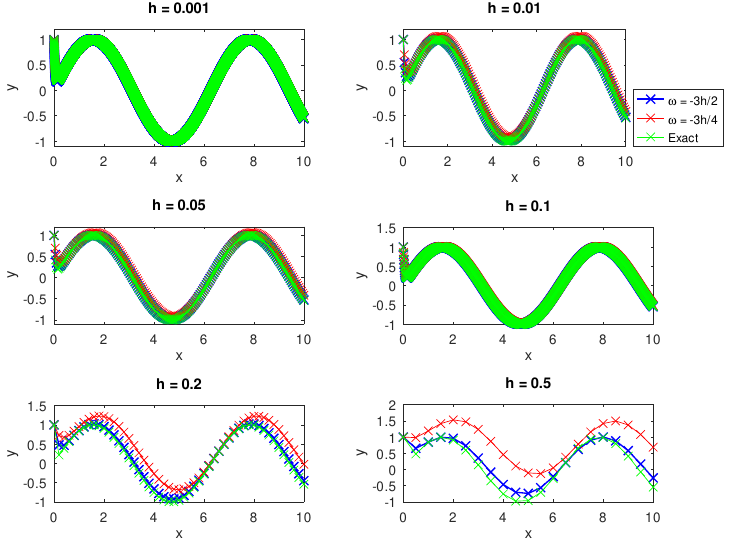
Figure 10. Comparison of the exact solution with those obtained from the discrete scheme (6) corre- Figure 10. Comparing the exact solution with those obtained from the discrete scheme (6) corre- 3 h sponding to ω = and the discrete scheme (10) corresponding to ω = 3 h sponding to ω = and the discrete scheme (10) corresponding to ω = 4 − 4 − method. We substituted f ( x , y ) = 9 y into each of the discrete schemes (3)–(6), (7)–(10), (11) − and (12) for h = 0.001, h = 0.01, h = 0.05, h = 0.1, h = 0.2, h = 0.5 and n . The results of